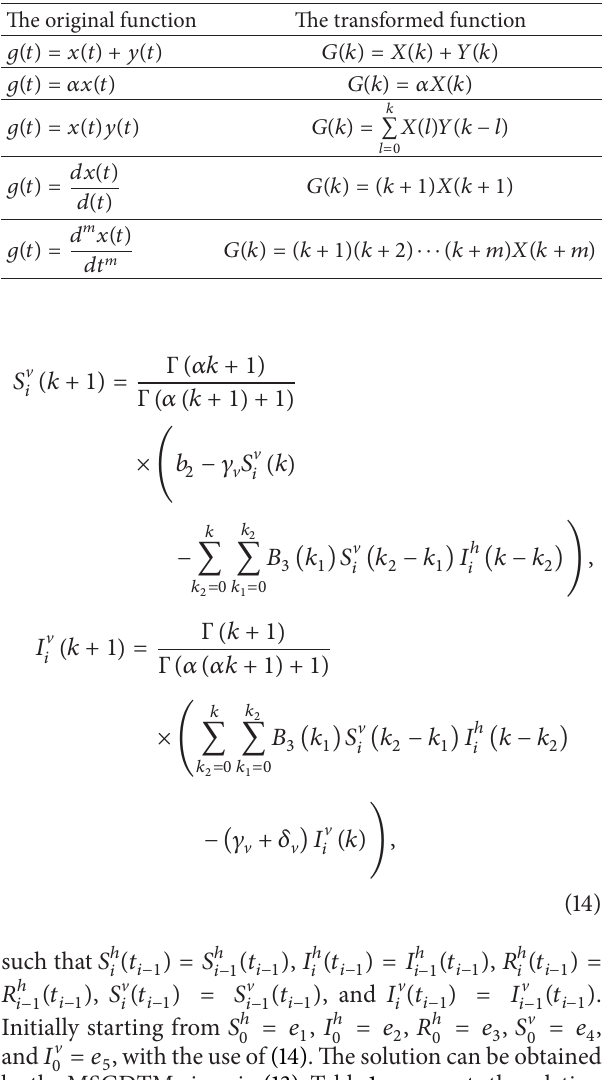
Figure 2: Comparison of RK method (dotted line) and MSGDTM (solid